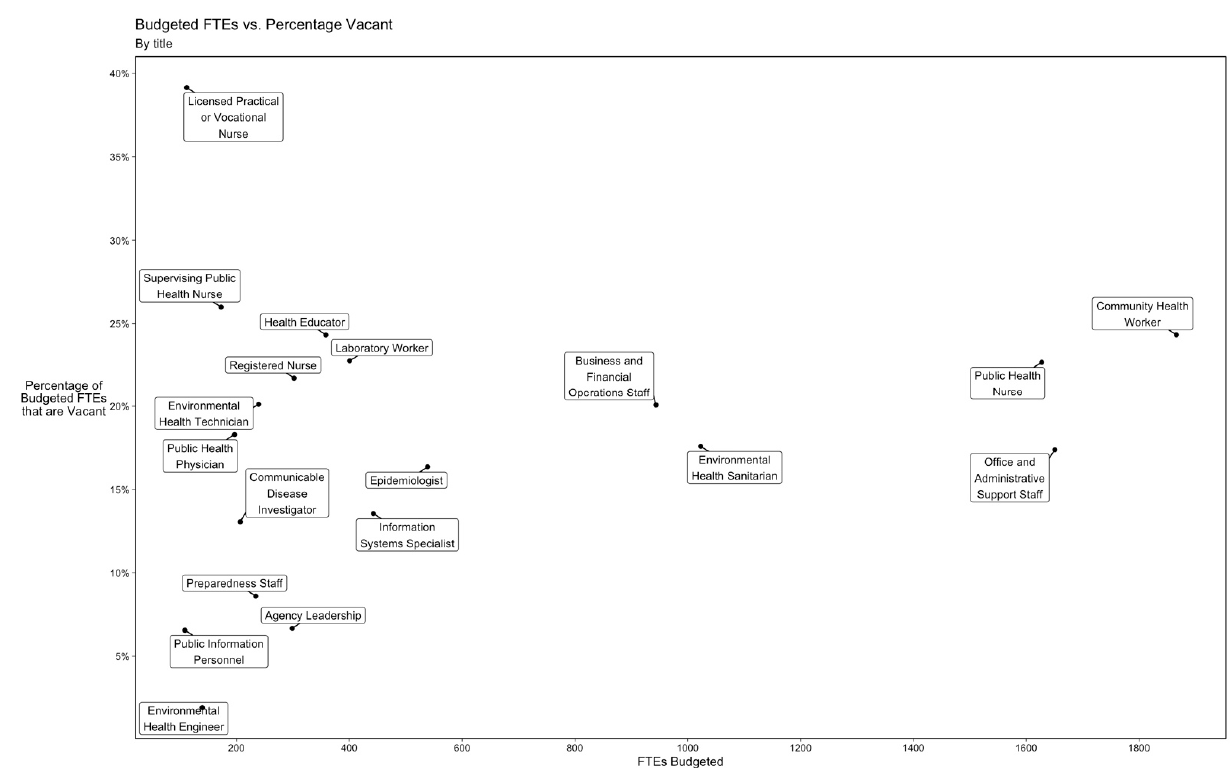
adjust for nonparticipation. to